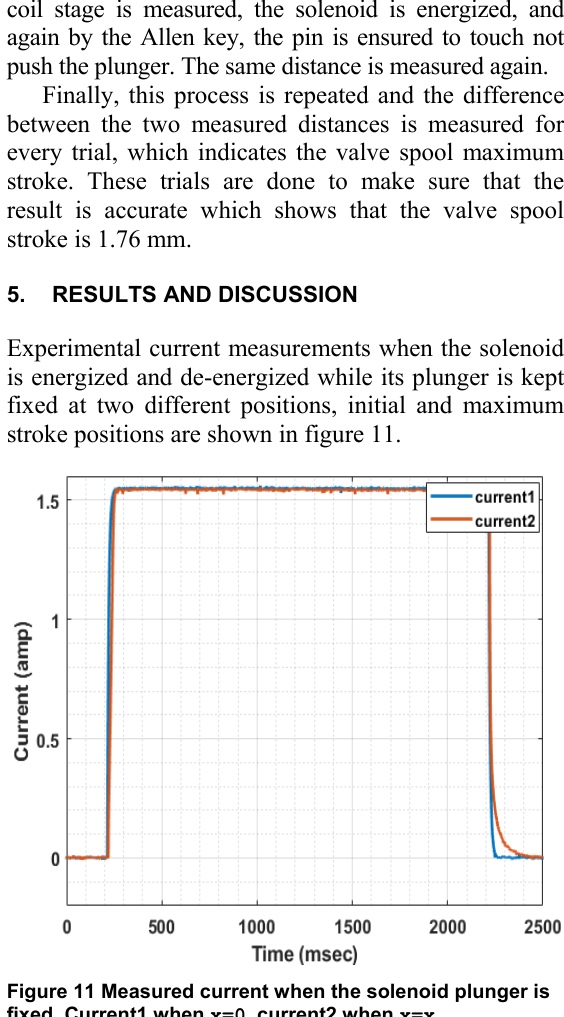
Figure 13 Current measured when the solenoid is de- energized under no applied hydraulic force and pressure difference ∆ P = 3MPa, 4 MPa, and 5